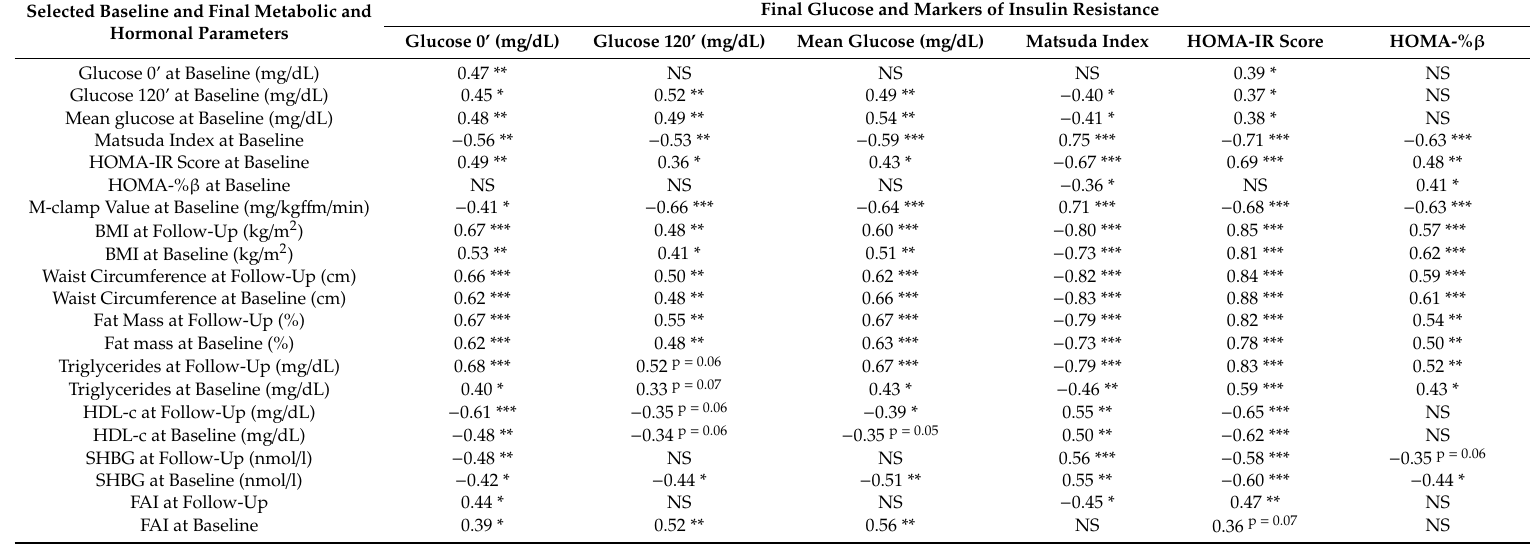
Table 5. Correlations between final concentrations of glucose, markers of insulin resistance and hyperinsulinaemia, with selected anthropometric, metabolic and hormonal parameters. Selected Baseline and Final Metabolic and Hormonal